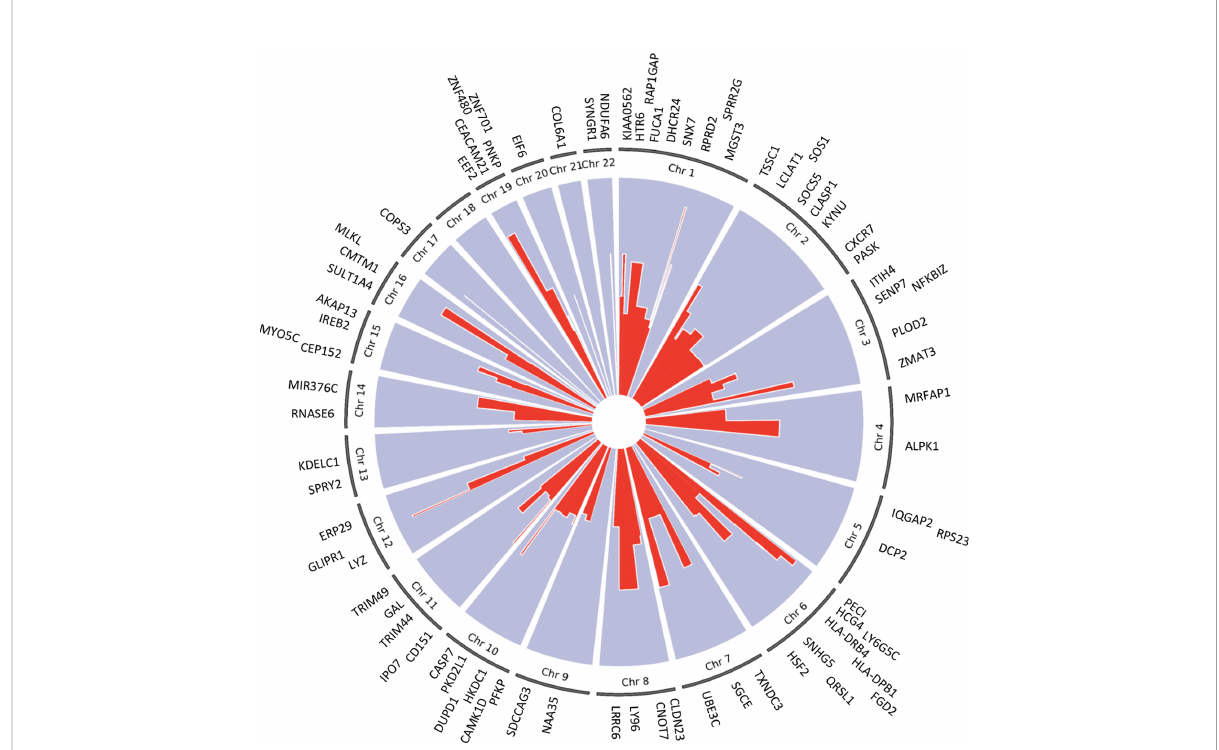
FIGURE 1 Circos plot of 81 eGenes mediating effects of cis-eQTLs on ascension (FDR <0.2) and their chromosome number. The -log 10(FDR) mediation test results for each eGene are represented by the red lines. The width of the red lines indicates the size of each gene. The eGenes are labeled at their respective chromosome base pair location